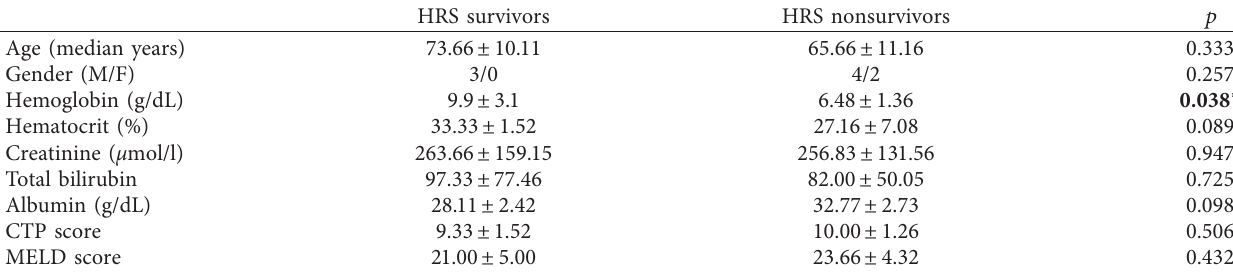
Table 5: Clinical and biological features of survivor and nonsurvivor patients with type 2